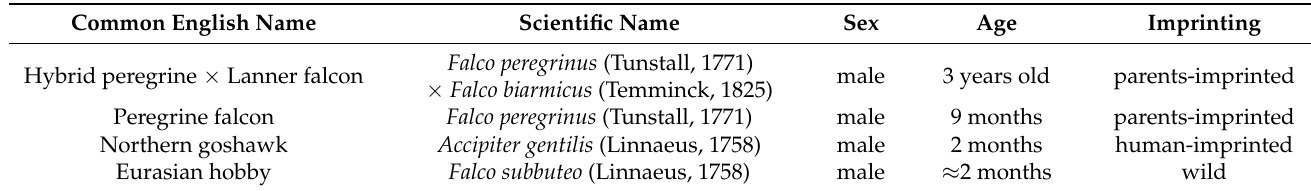
Table 1. Signaling of the four raptors trained with the new high-tech